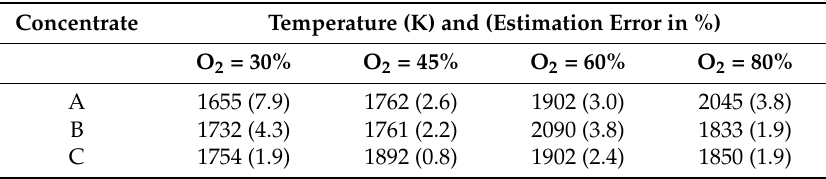
Table 4. Copper concentrates estimated temperature 1 .